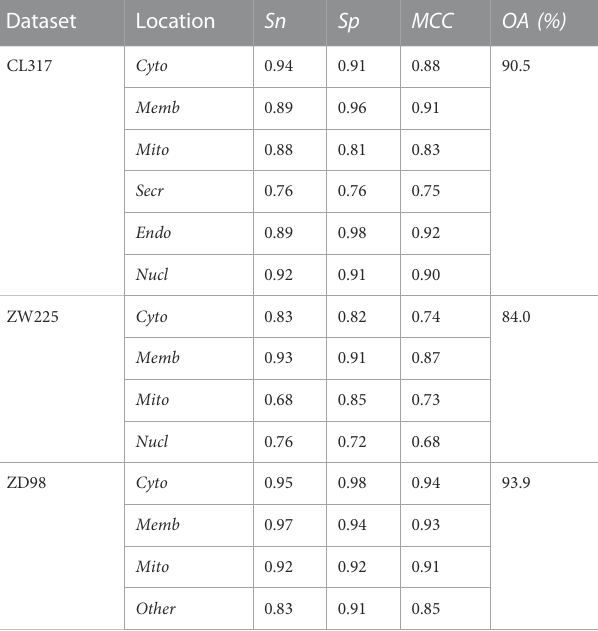
TABLE 2 Comparison of prediction performance for different methods on the CL317 dataset.